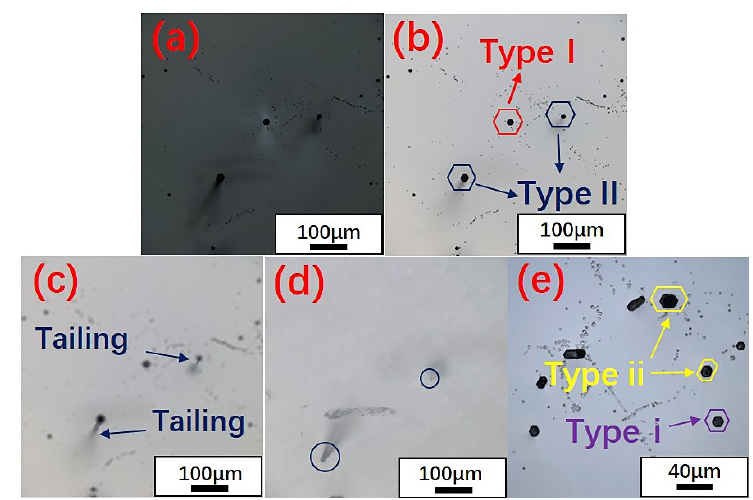
Figure 7. Classification of 4H-SiC micropipe etch pits: ( a ) transmitted polarized microscopic image of the area shown in ( b ); ( b ) Type II and Type I micropipe etch pits observed with a 20× lens; ( c ) tailing of Type II micropipe etch pits when the focal length was changed; ( d ) black spots formed on the back by the Type II micropipe etch pits; ( e ) micropipe etch pits of different shapes observed with a 50× lens.